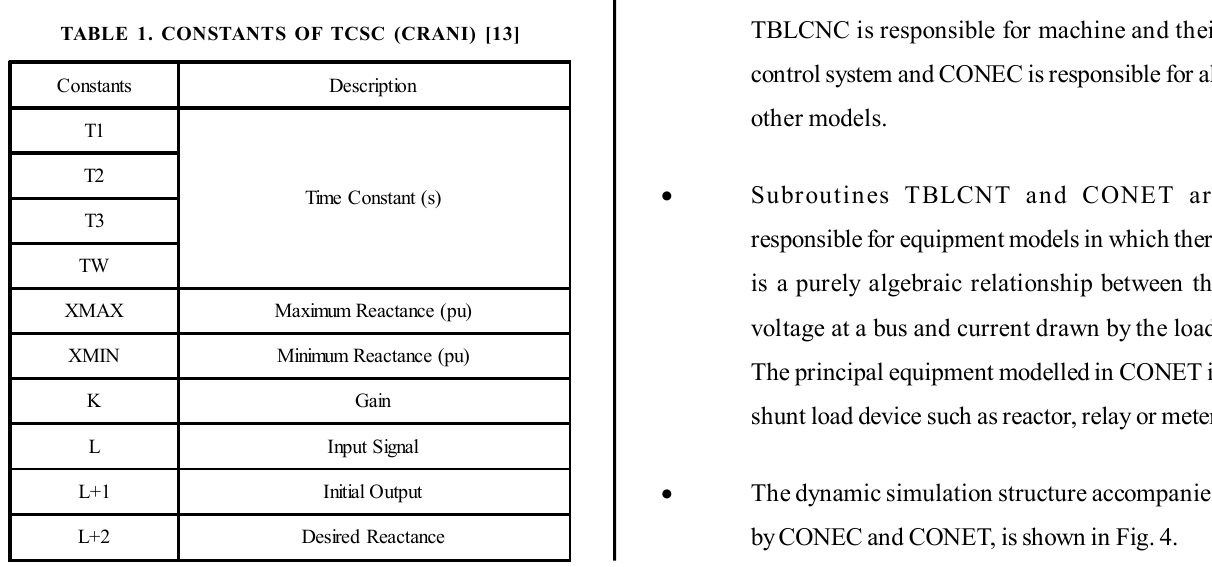
TABLE 1. CONSTANTS OF TCSC (CRANI)